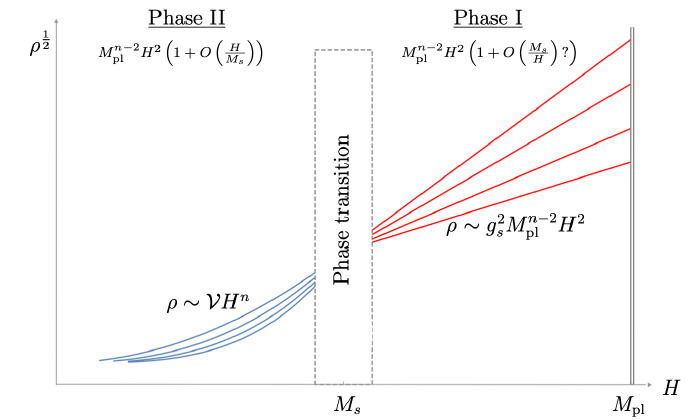
Figure 7 . Schematic behavior of the square root of the energy density in the perturbative case with M for dimensions n = 4 , 5 , 6 , 7 s (cid:28) M pl